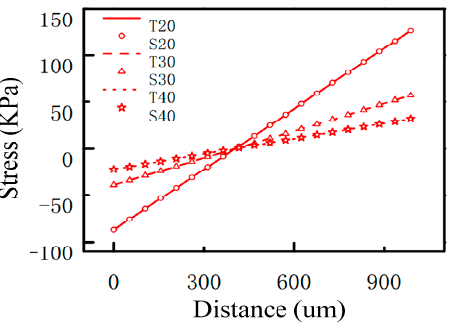
Figure 9. The effects of the width of the beam on the stress distribution.